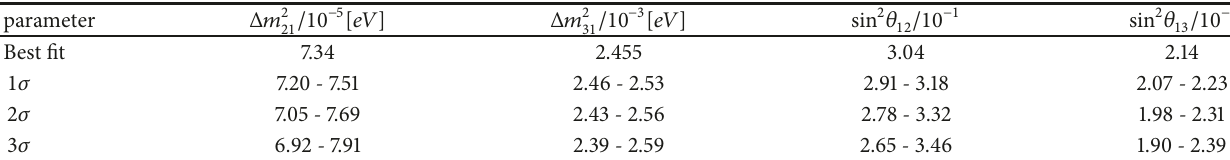
Table 1: Recent global data table for best-fit values of the oscillation parameters and their range at 1 𝜎 , 2 𝜎 , and 3 𝜎 in the case of three neutrinos with Normal Ordering spectrum [6].